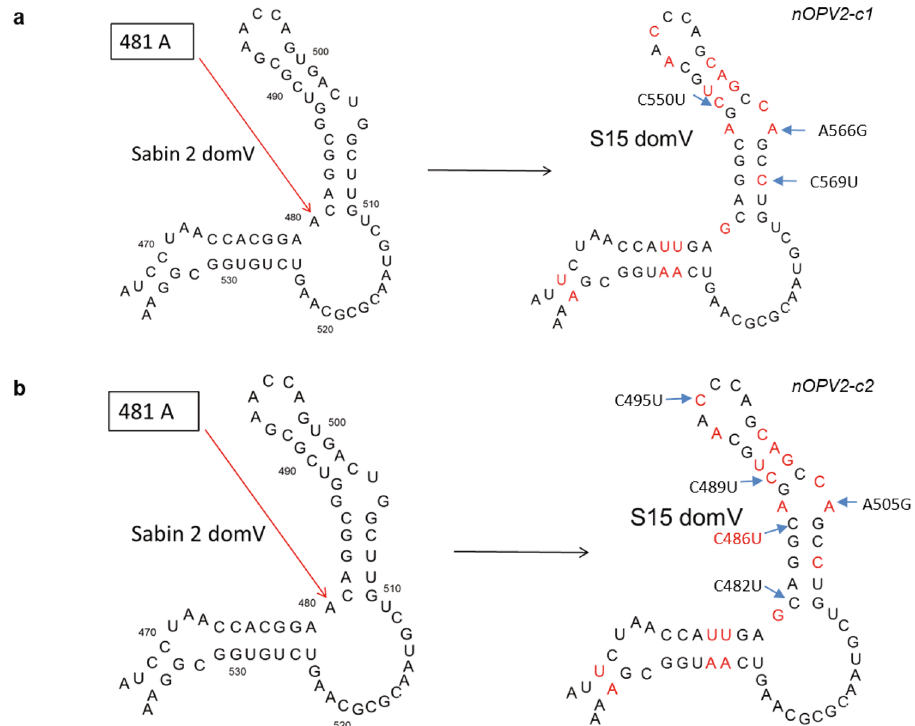
Fig. 6 Polymorphisms in predicted RNA secondary structure of S15 domain V. SNPs indicated by arrows. Polymorphism in red is present at high frequency in EES. Polymorphisms in black are present at variable frequency, but con fi rmed in replicates of the EES. a nOPV2-c1. b